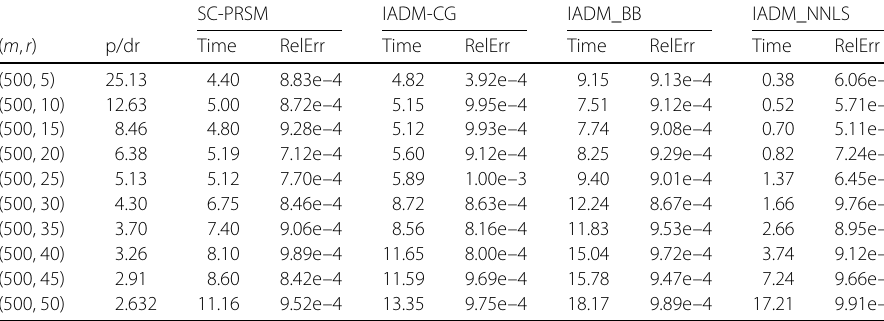
Table 3 SC-PRSM, IADM-CG, IADM_BB and IADM_NNLS for solving the matrix completion problems, m = n , sr =